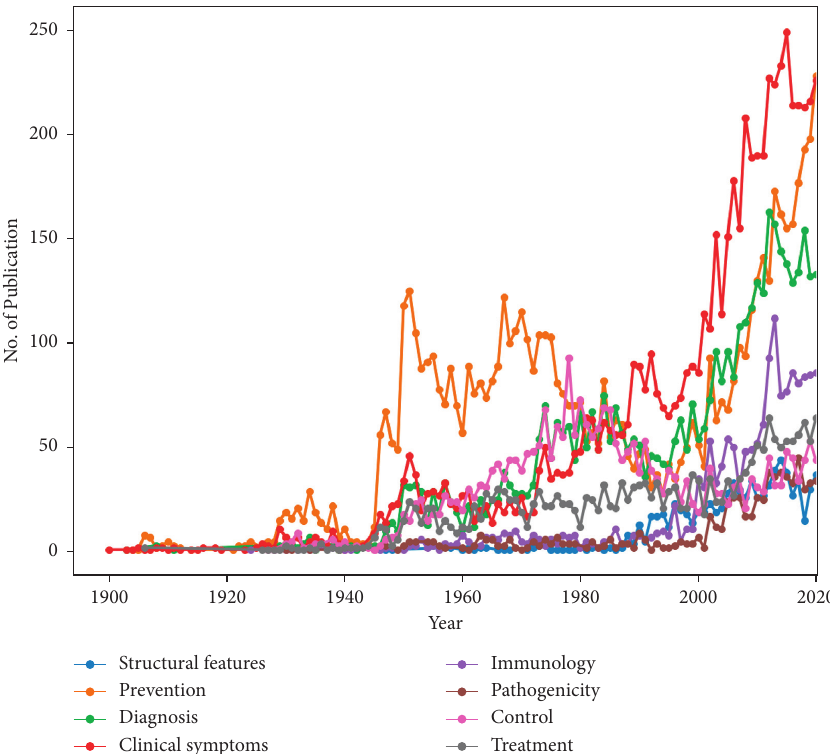
Figure 4: Publication trend of brucellosis publications over a period of